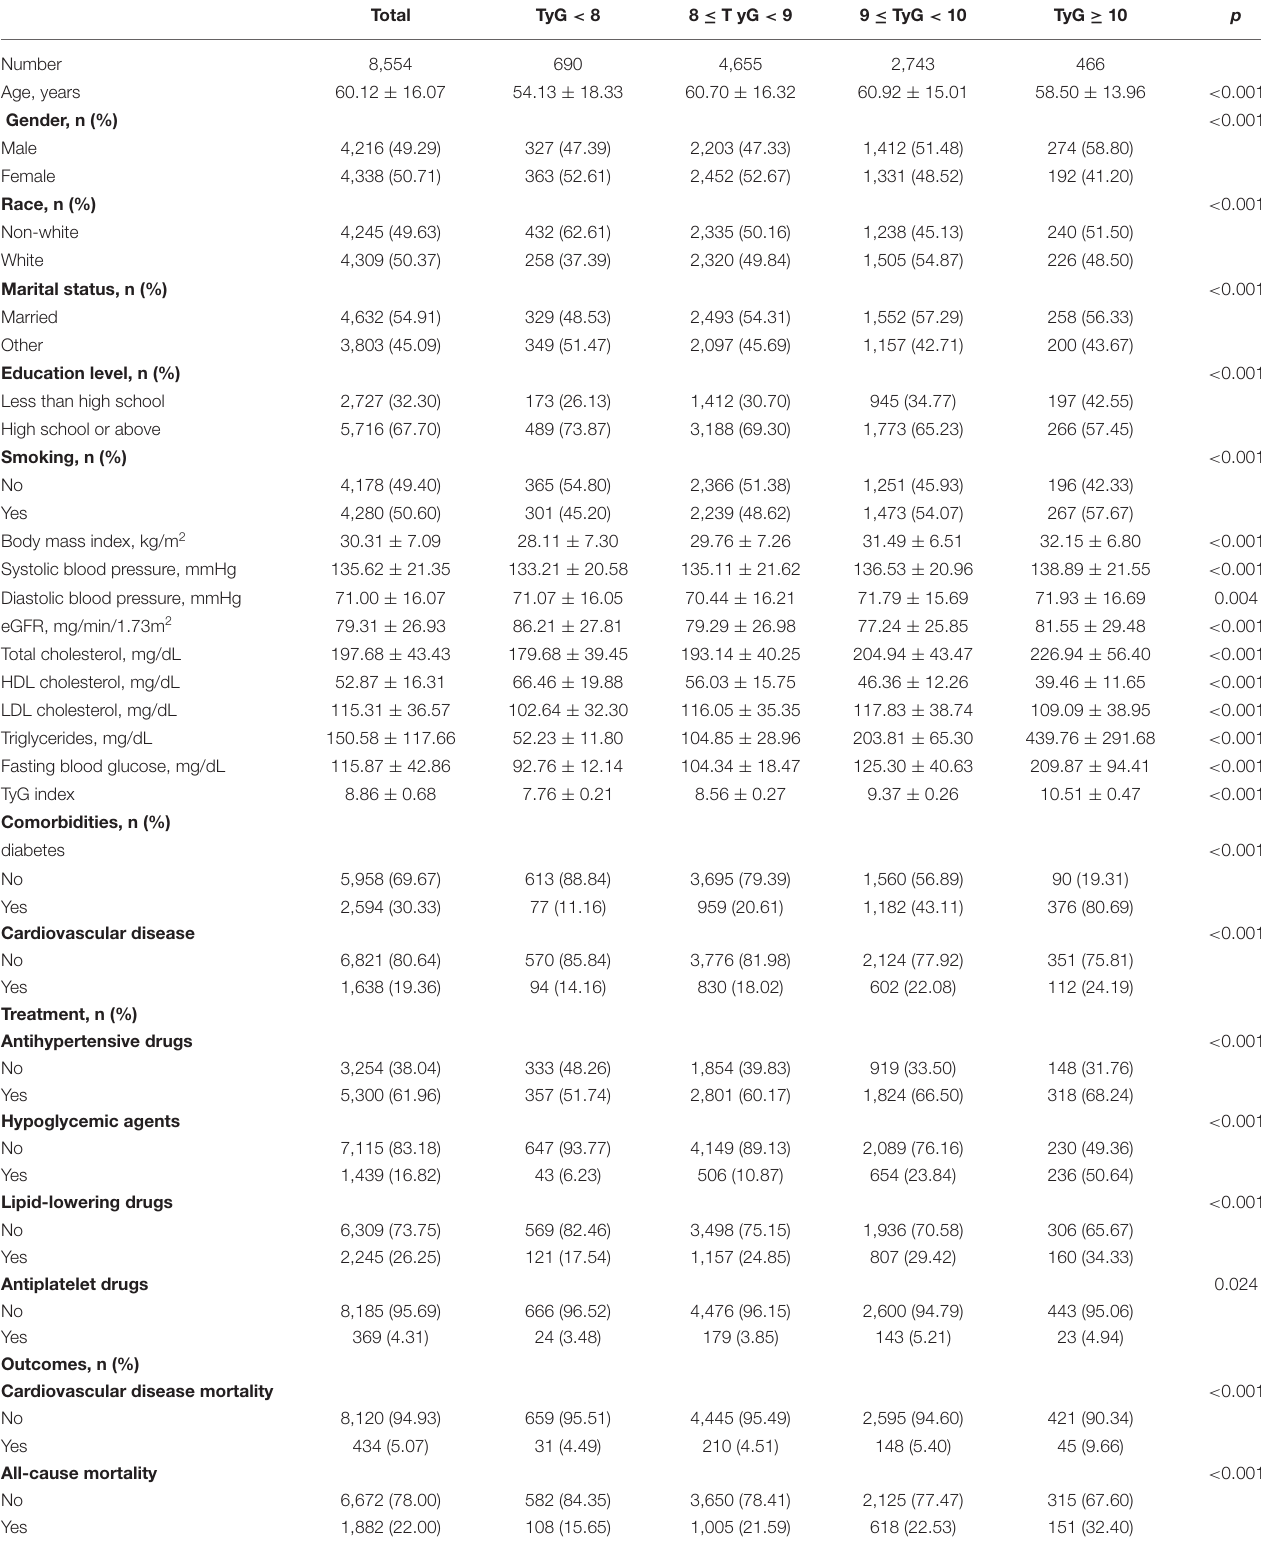
TABLE 1 | Demographic and clinical characteristics according to triglyceride-glucose index